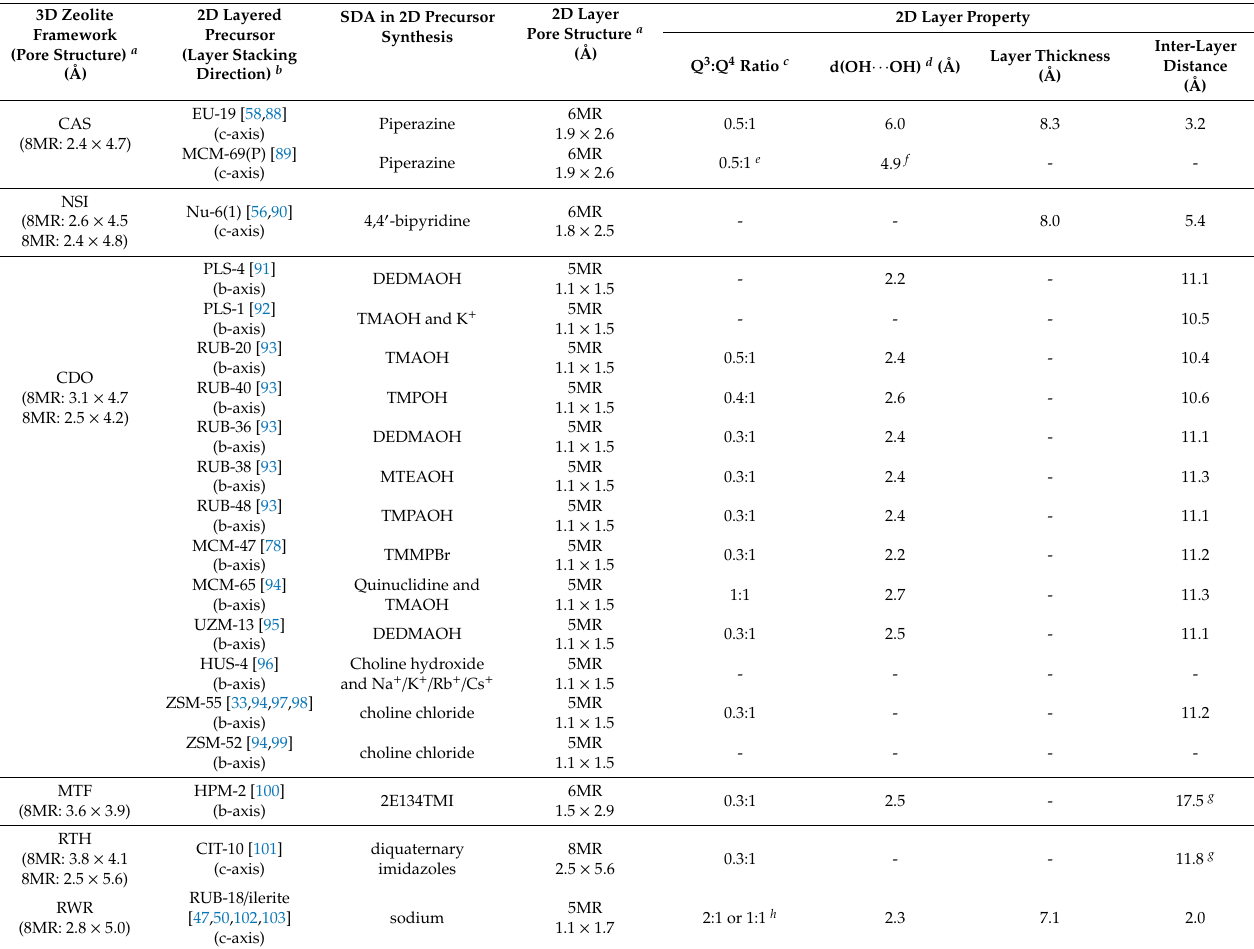
Table 2. Structural properties of 2D layered precursors and their related 3D (8-MR)